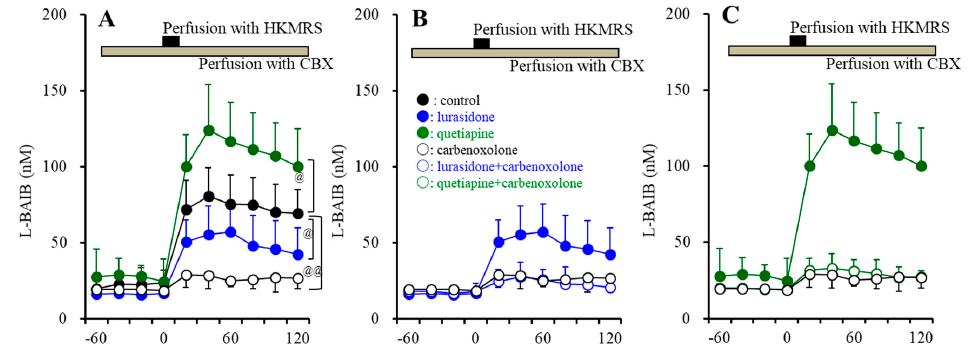
Figure 5. Effects of chronic administration of effective doses of lurasidone (( B ): Lur: 1 mg/kg/day for 14 d), quetiapine (( C ): QTP: 10 mg/kg/day for 14 d), and perfusion with 100 µ M carbenoxolone (CBX: Figure 5. E ff ects of chronic administration of e ff ective doses of lurasidone (( B ): Lur: 1 mg/kg/day for hemichannel inhibitor) on HKMRS-evoked L-BAIBA release in the hypothalamus using microdialysis. Ordinates indicate mean ± SD ( n = 6) of extracellular L-BAIBA level (nM). Abscissas indicate time after HKMRS-evoked stimulation (100 mM K + containing perfusate) (min). Black and grey columns indicate the perfusion with HKMRS for 20 min and perfusion with carbenoxolone (100 µ M) containing perfusate into the hypothalamus, respectively. @: p < 0.05, @@: p < 0.01: relative to control ( A ) by multivariate analysis of variance (MANOVA) with Tukey’s post hoc